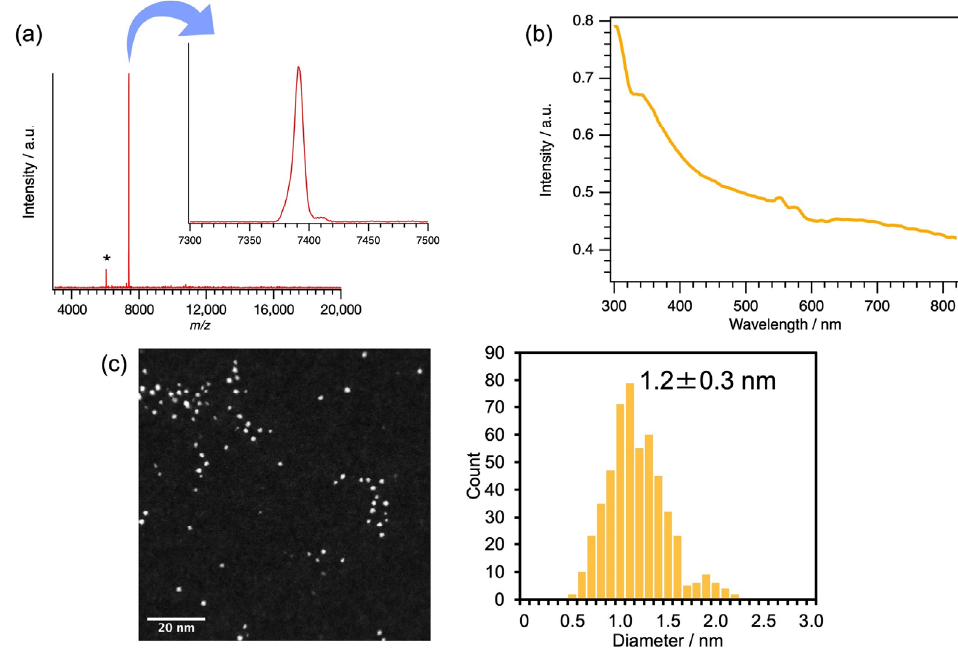
Figure 2. Characterization of the Au 25 PET 18 . ( a ) MALDI-TOF-MS spectra (* is a fragment peak), ( b ) UV-Vis absorption spectrum and ( c ) a STEM image and the particle size distribution of the Au 25 PET 18 sample.